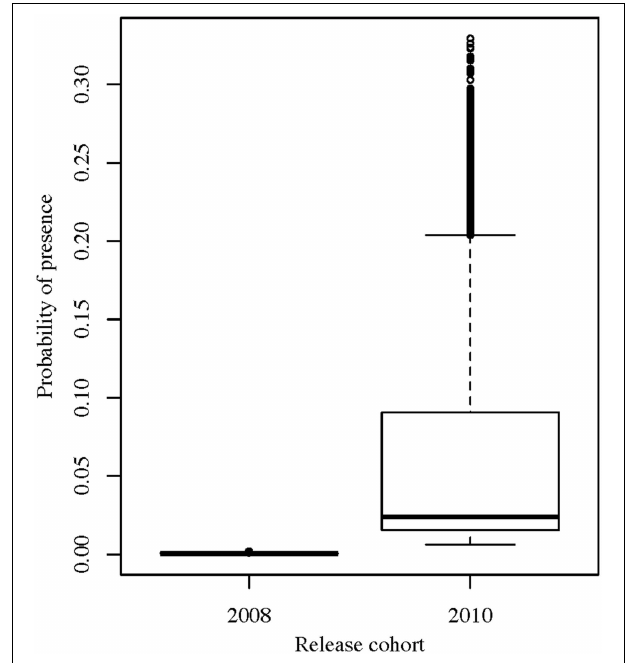
FIGURE 7 | Predicted values from the best GLMM model for the probability of captive-bred wobbegongs from the 2008 and 2010 cohorts being present at